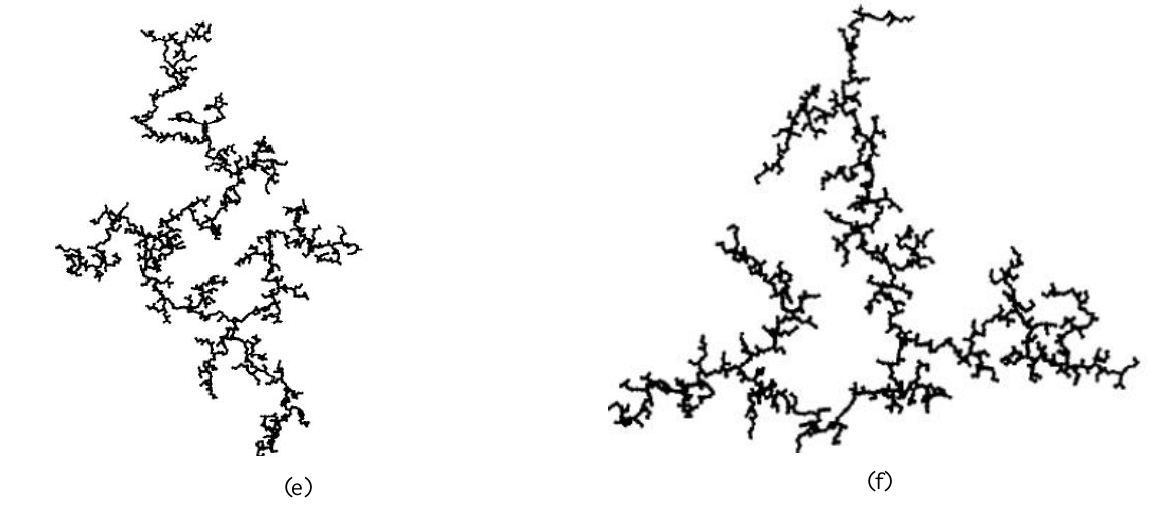
Fig. 2. Ending . Computer models of formation of casein clusters: (a) DLA, (b) BLA, (c) RLA, (d) DLCA, (e) RLCA, and (f) BLCA.